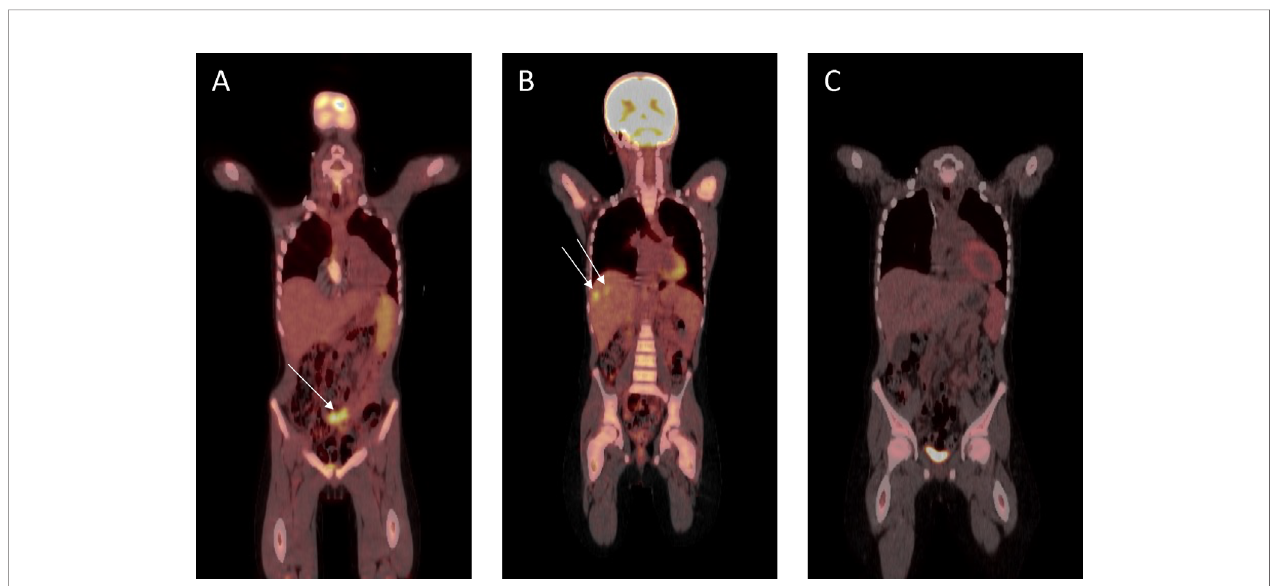
FIGURE 4 | Fluorodeoxyglucose – positron emission tomography scan response assessment during therapy. (A) Very good partial response prior to surgical resection. (B) At hepatic progression (metastatic lesions to segments 7 and 8 shown). (C) Complete remission prior to metronomic maintenance